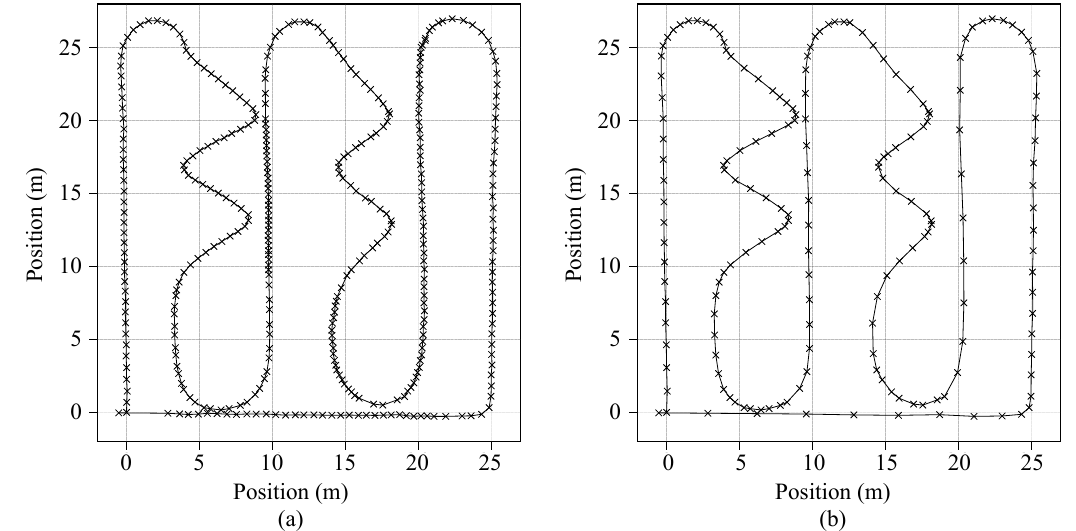
Figure 8. The recovered trajectories derived from ( a ) the straight-forward method and ( b ) the proposed DCNN-based